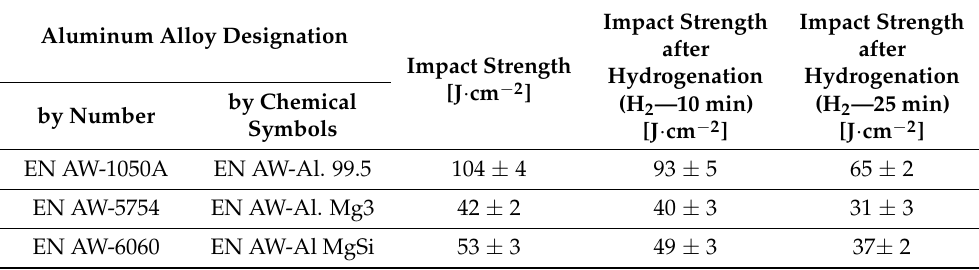
Table 2. Experimental data on impact strength measurements, before and after hydrogenation.